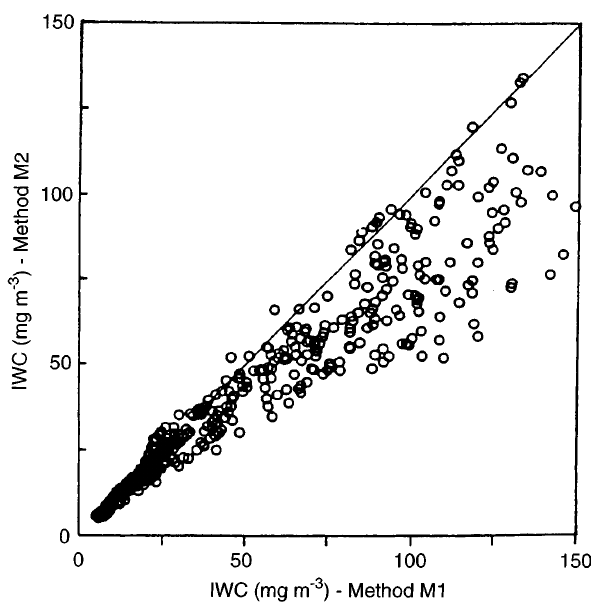
Fig. 2. Comparison of the ice water content ( IWC ) obtained from two methods of data processing (M1, M2) applied to a same data set (cirrus measurements performed near ) 30 (cid:176) C during mission 210 of the International Cirrus